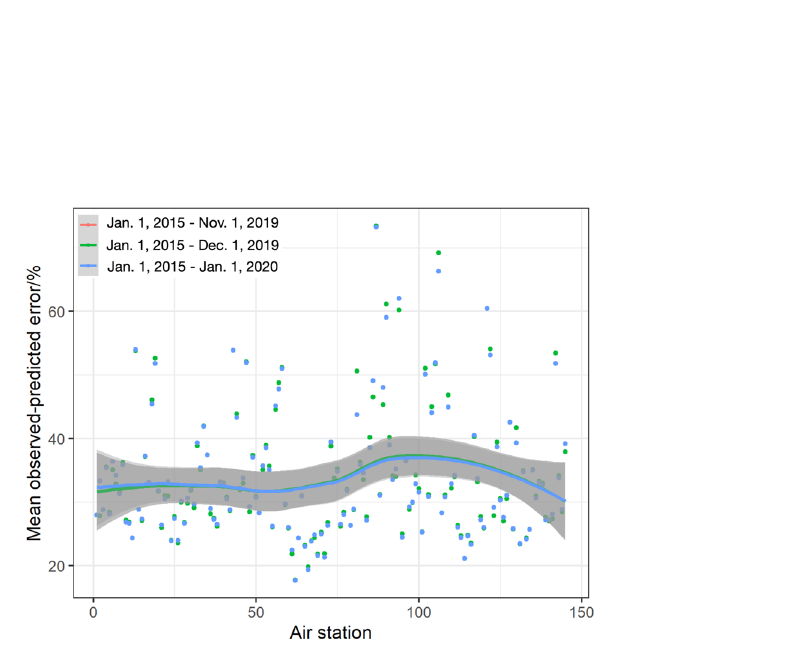
Figure 2. Mean daily observed-predicted NO 2 errors based on training data from three time periods, including Jan. 1st, 2015 to Nov. 1st, 2019, from Jan. 1st, 2015 to Dec. 1st, 2019 and from Jan. 1st, 2015 to Jan. 1st, 2020, to determine the time period of training data for SARIMAX